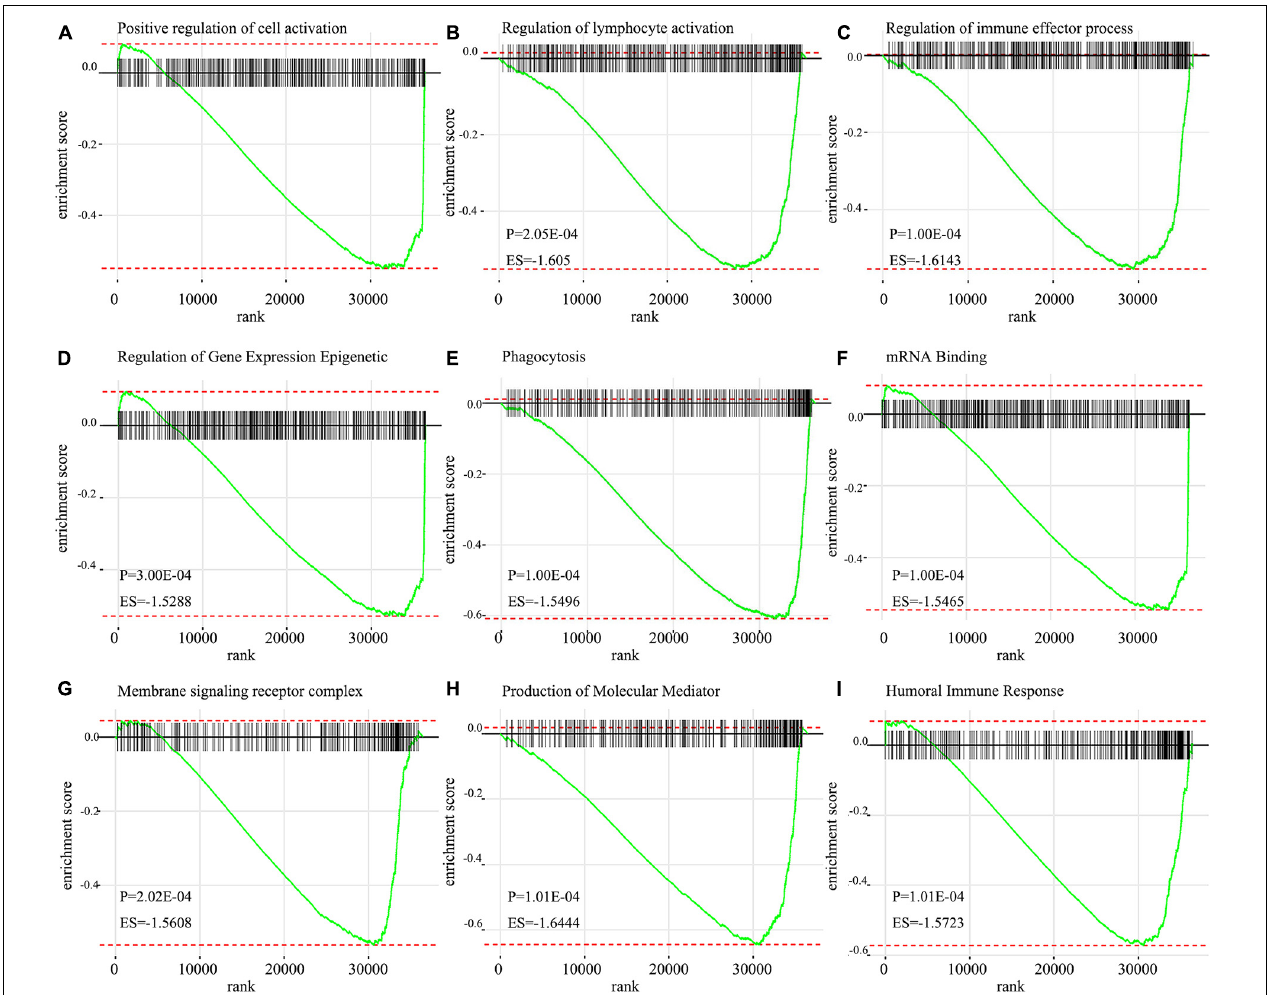
FIGURE 7 | GSEA enrichment plots from gene set enrichment analysis. The results show that nine cancer hallmark gene set included (A) positive regulation of cell activation, (B) regulation of lymphocyte activation, (C) Regulation of immune effector process, (D) Regulation of gene expression epigenetic, (E) Phagocytosis, (F) mRNA binding, (G) Membrane signaling receptor complex, (H) Production of molecular mediator, (I) Humoral immune response are significant enrichment of low score of immune-related pathways in patients with HNSCC ( P <